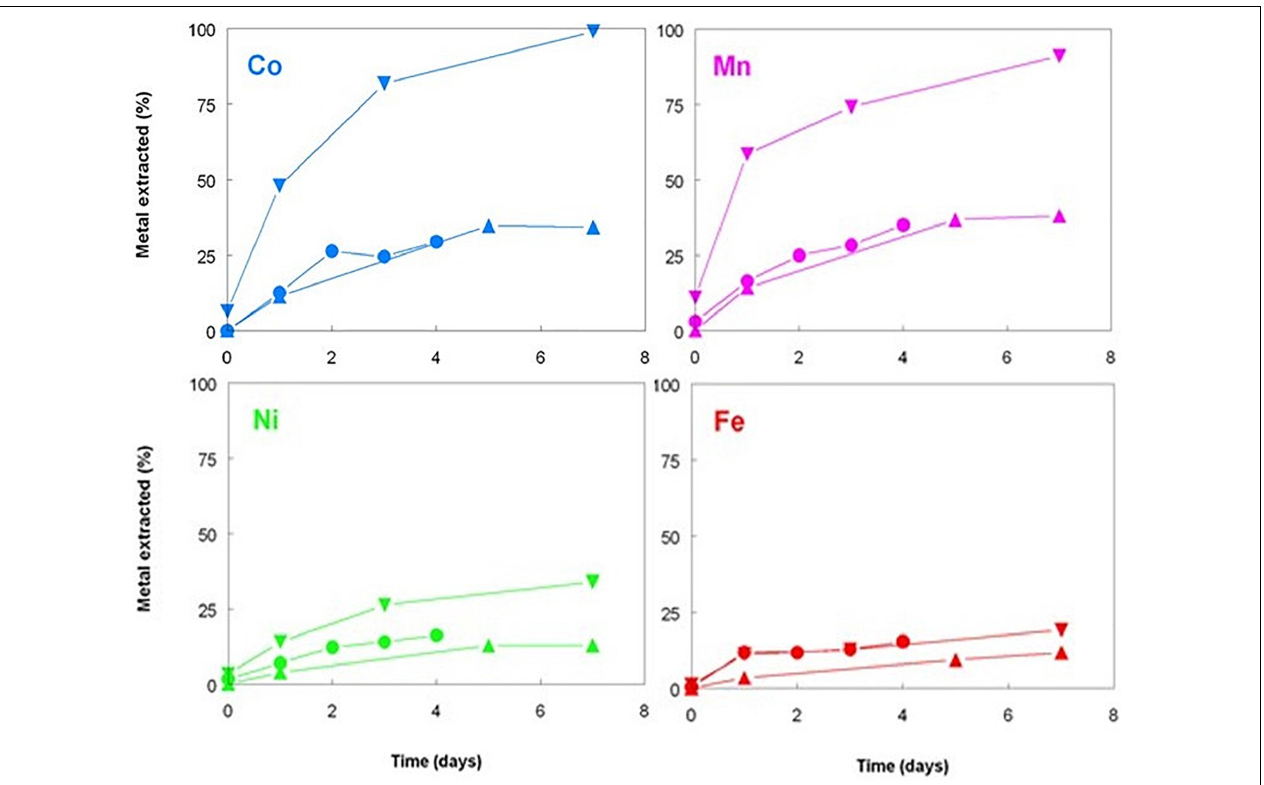
FIGURE 5 | Changes in concentrations of base metals during leaching of New Caledonian limonite at 50 ◦ C and pH 1.0, in the presence of sterile sulfur powder ( (cid:78) ), bio-ZVS ( (cid:72) ), and no added sulfur